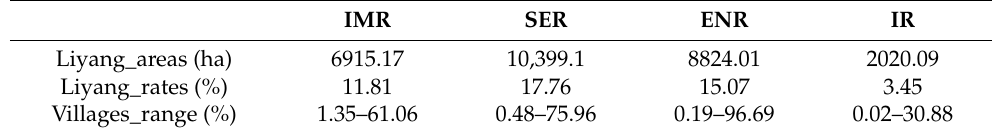
Table 3. Areas and rates among non-grain production categories in Liyang, China. IMR SER